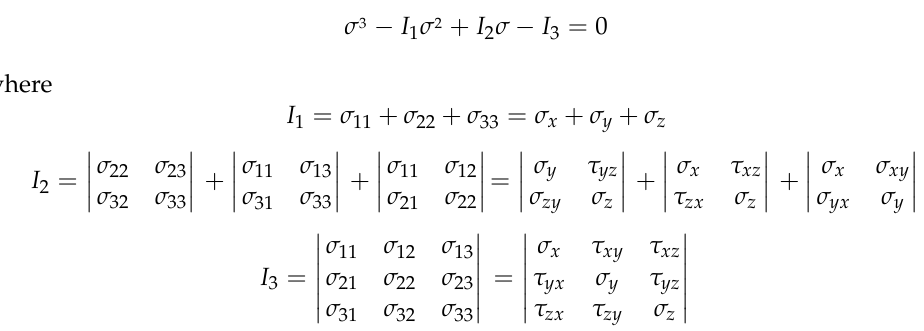
Figure 6. Mohr’s circle when any point of the material reaches equilibrium state ( a ) microelement, ( b ) Mohr’s circle.